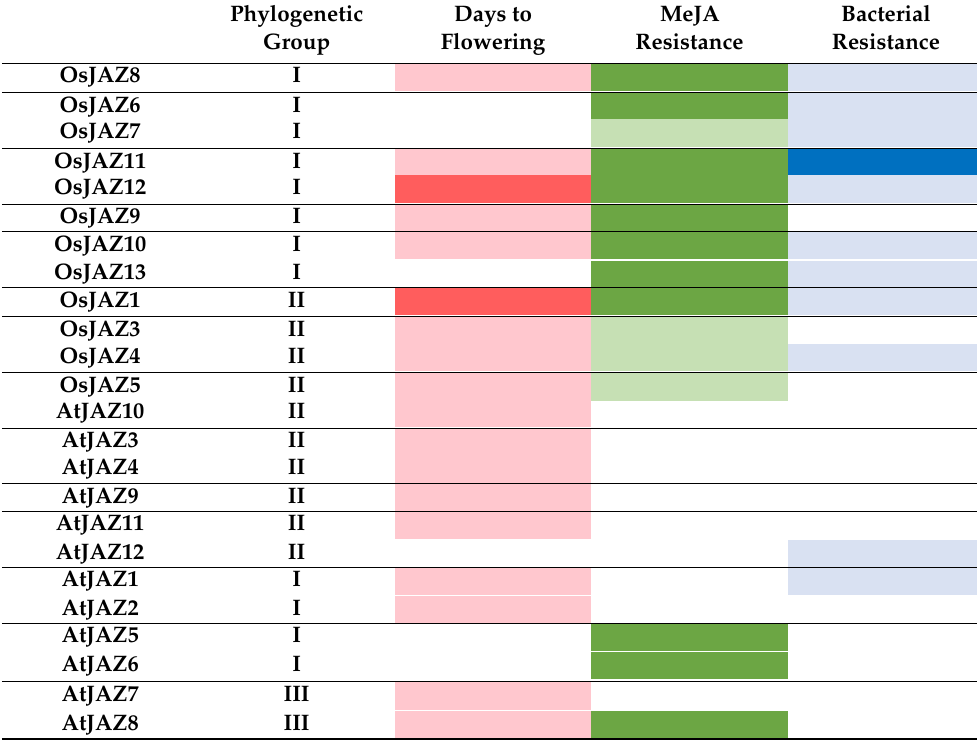
Table 2. Summary of the JAZ OE phenotype and JAZ proteins homology. ”I”, ”II”, ”III” represent the group of JAZ proteins in the evolutionary tree. The dark red fills represents that the transgenic line flowered later than Col-0, the light red fills represents that the transgenic line flowered earlier than Col-0; The dark green fills represents that the MeJA resistance of the transgenic line is higher than that of Col-0, the light green fills represents that the MeJA resistance is lower than that of Col-0; The dark blue fills represents that the bacterial resistance of the transgenic line is higher than that of Col-0, the light blue fills represents that the bacterial resistance is lower than that of Col-0; All white fills represent that the phenotype of the transgenic line is not significantly different from Col-0. The black box represents that the JAZ protein in it is located on the smallest branch of the evolutionary tree. Phylogenetic Days to MeJA Bacterial Group Flowering Resistance Resistance OsJAZ8